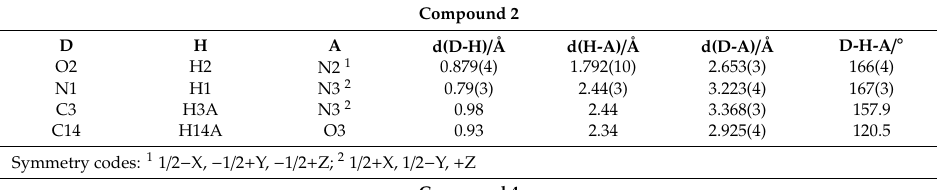
Table 2. Hydrogen bond interactions for compounds 2 , 4 , and 9